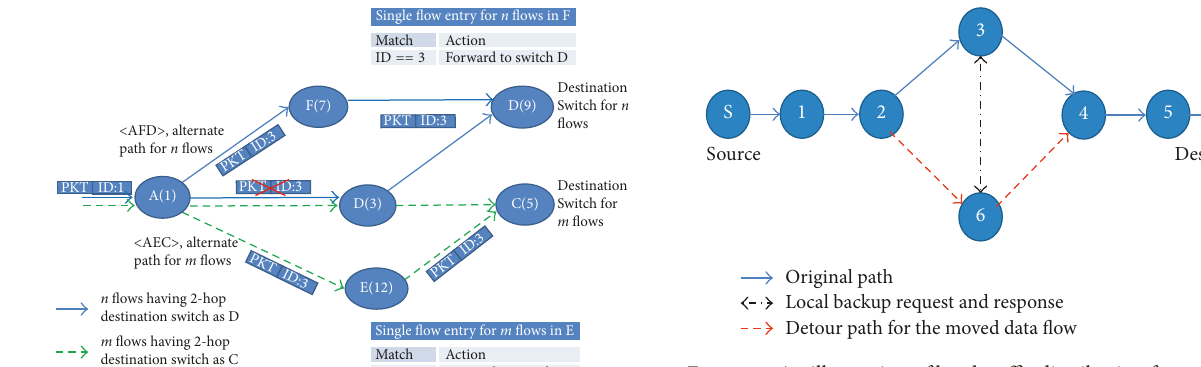
Figure 5: An illustration of local traffic distribution for node failure recovery model in MCWNs [44].